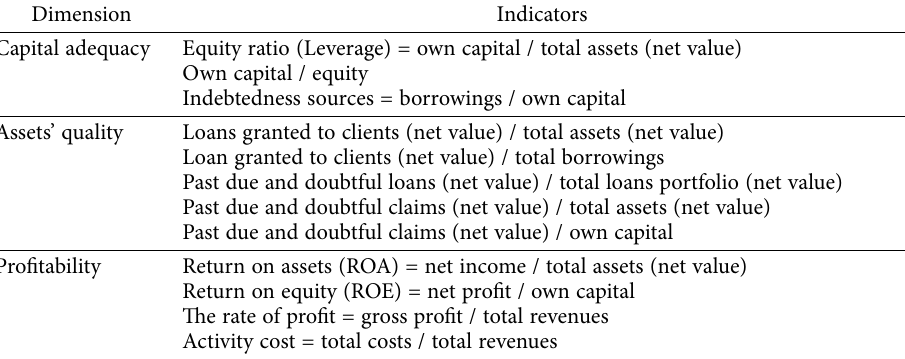
Table 1. The performance dimension and the corresponding financial ratios Dimension Indicators Capital